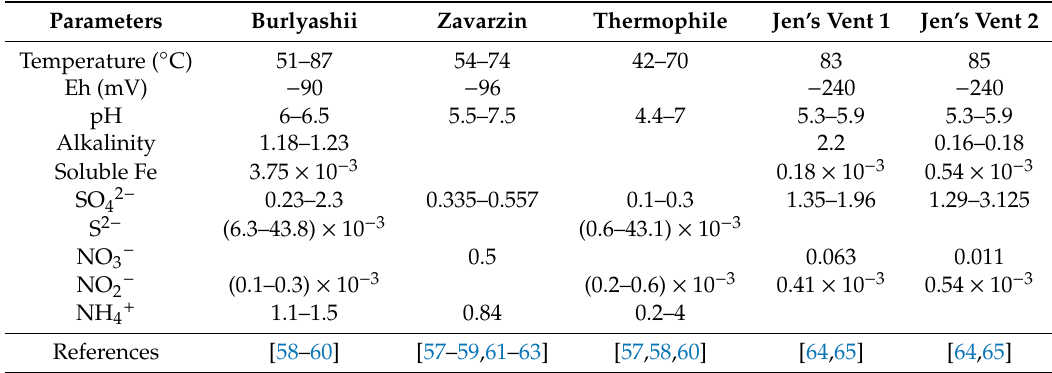
Table 1. The geochemistry of Kamchatka hot springs. All concentration values are in mmol / l unless otherwise